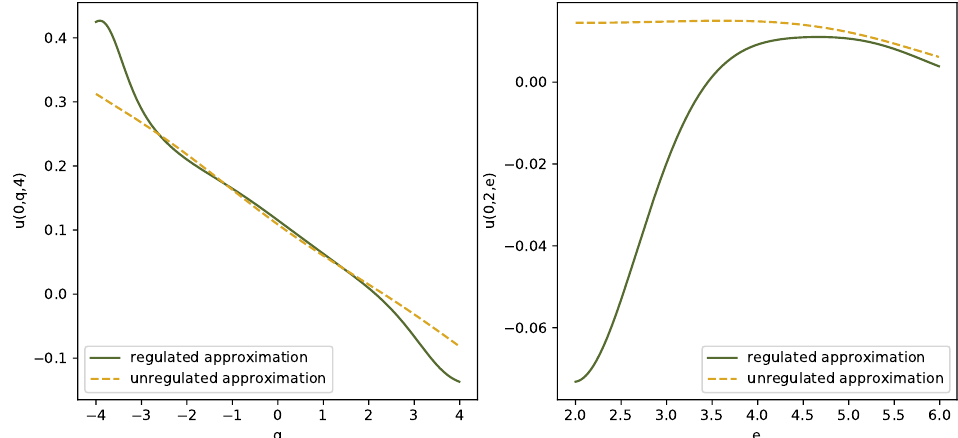
Figure 9. DNN-approximations of the optimal strategy θ ∗ unregulated case ( orange ) on { ( q ,4 ) : q ∈ [ − 4,4 ] } ( left ) and on { ( 2, e ) : e ∈ [ 2,6 ] } ( right